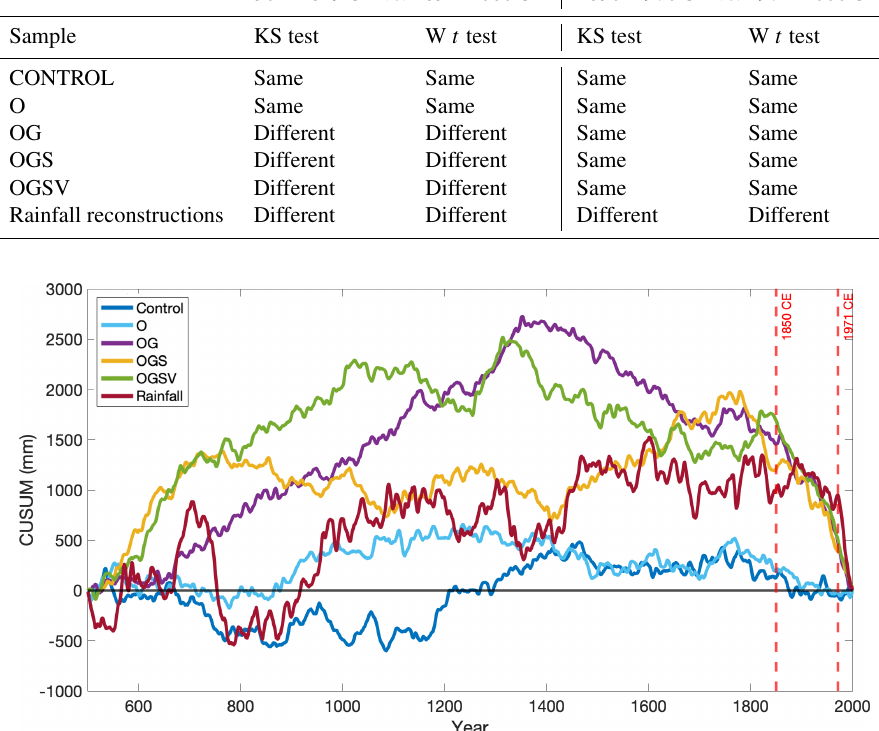
Figure 7. CUSUM time series for the rainfall reconstruction and CSIRO Mk3L model rainfall simulations in the MASK region from 501 to 2000CE. The model simulations include CONTROL (pre-industrial control simulation; Phipps et al., 2013a), O, OG, OGS and OGSV. The black horizontal line represents zero. The red vertical dashed lines highlight the years 1850 and 1971CE.